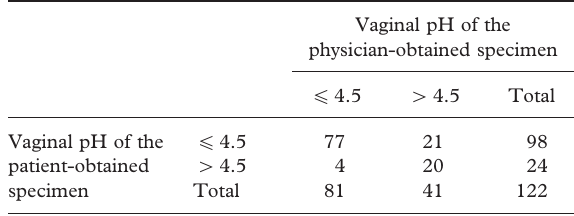
Table II. *Comparison of dichotomous coding of vaginal fluid pH collected by the two